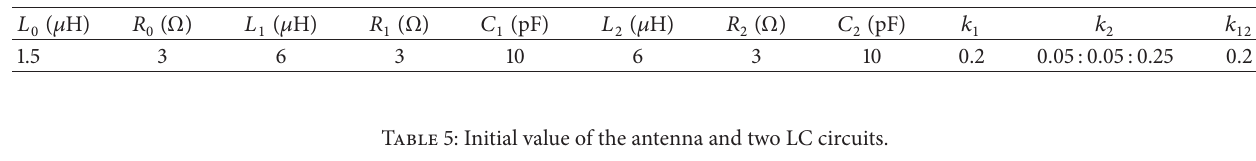
Table 4: Change of 𝑘 2 .